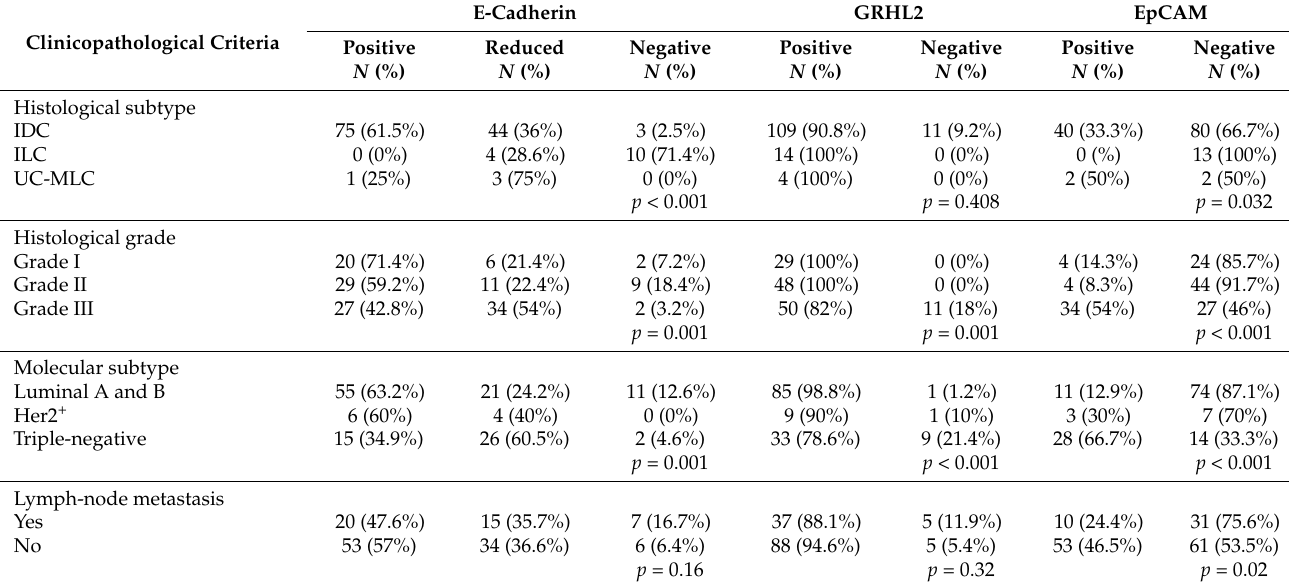
Table 4. Correlation between the level of protein expression of epithelial markers and clinicopathological criteria.